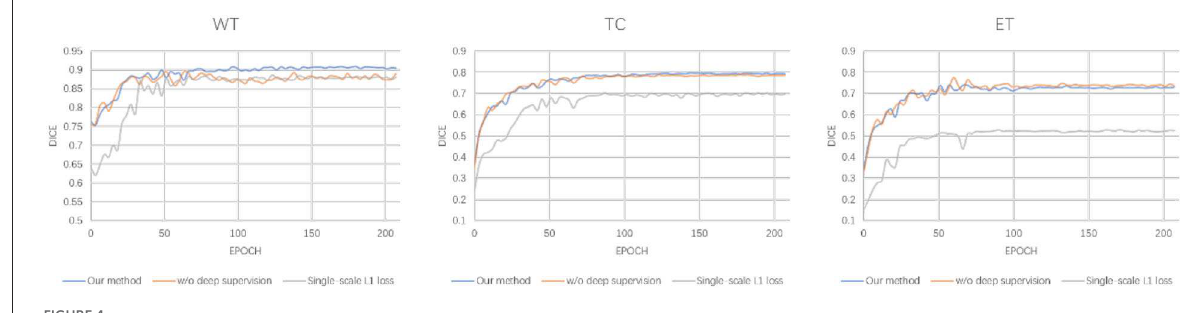
FIGURE4 Detailed evaluation curves of different loss function.